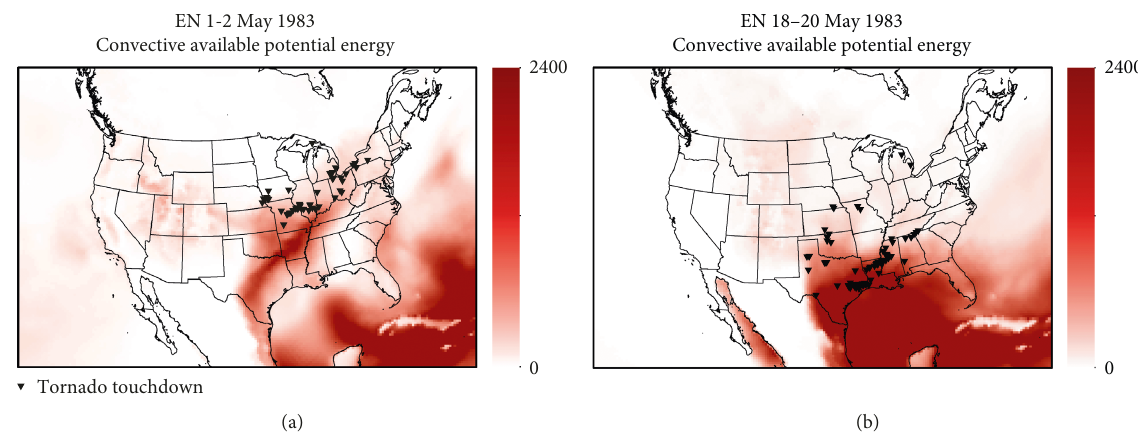
1 ) on (a) 1-2 May 1983 and (b) 18–20 May 1983, when 39 and 51 tornadoes occurred, respectively. Figure 9: CAPE (J kg · −